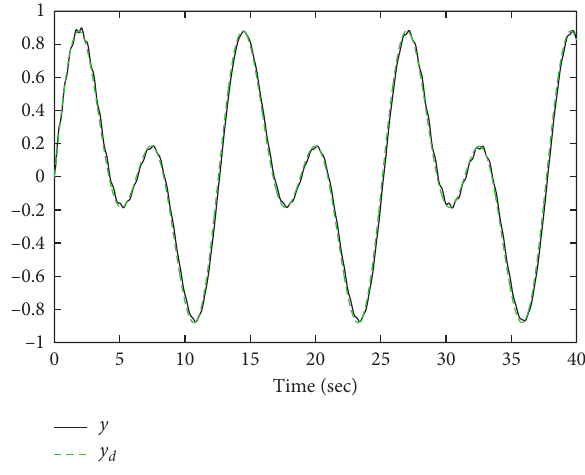
Figure 1: The response of the variables y and y